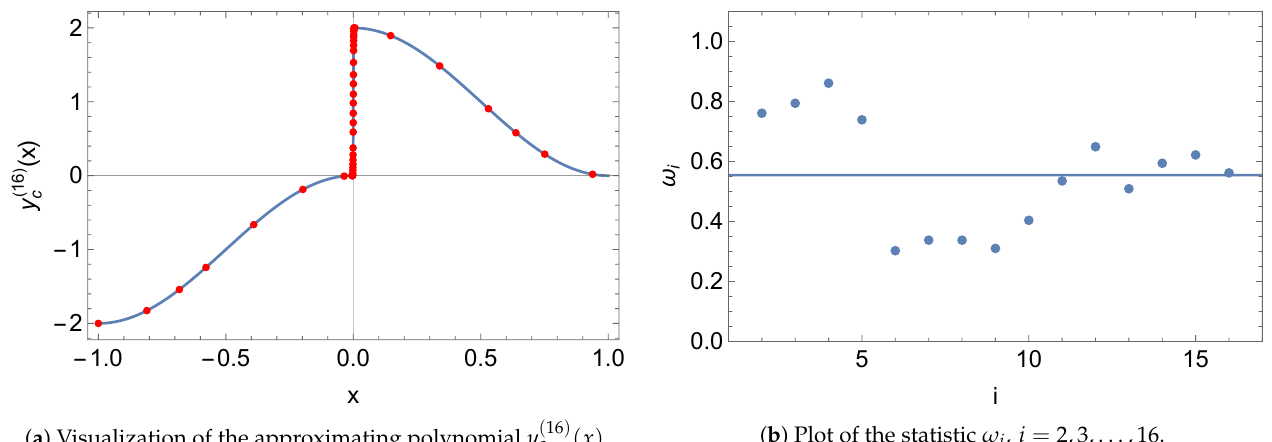
( b ) Plot of the statistic ω i , i = 2,3, . . . ,16. ( 16 ) ( x ) . A proper subset of the set of points S is shown. c